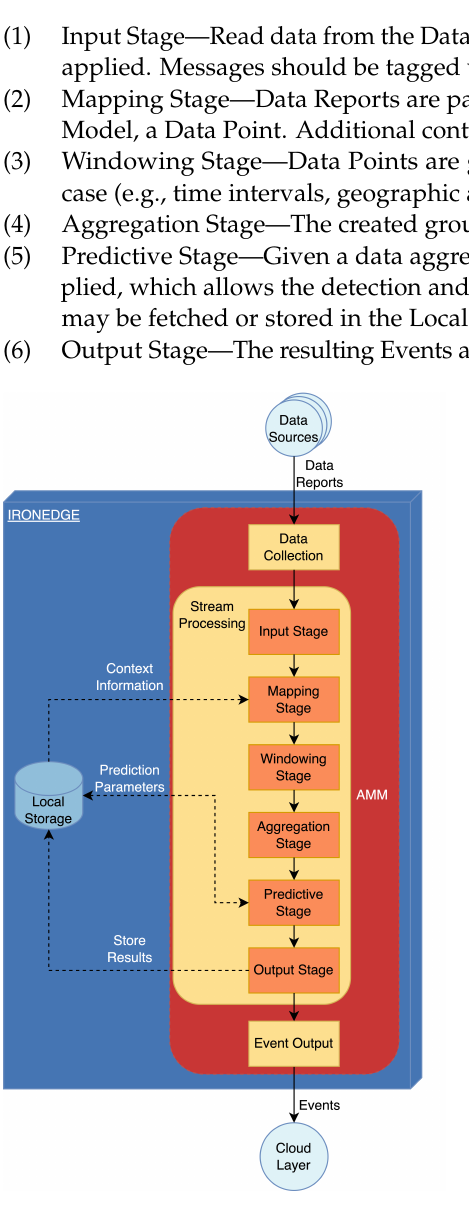
Figure 3. Processing pipeline for approximation of workloads. Including connections with Local Storage and external